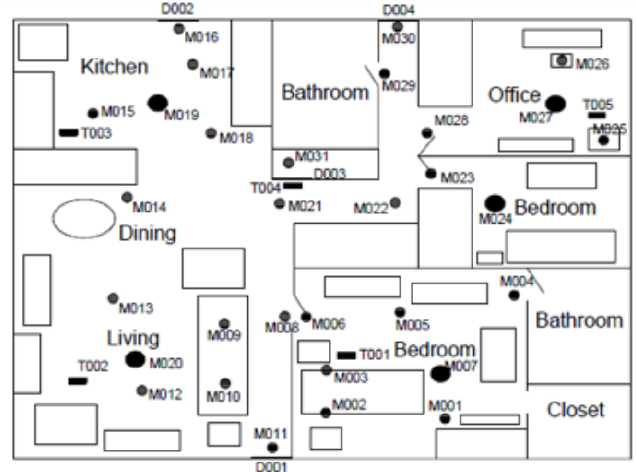
Figure 8. Aruba test